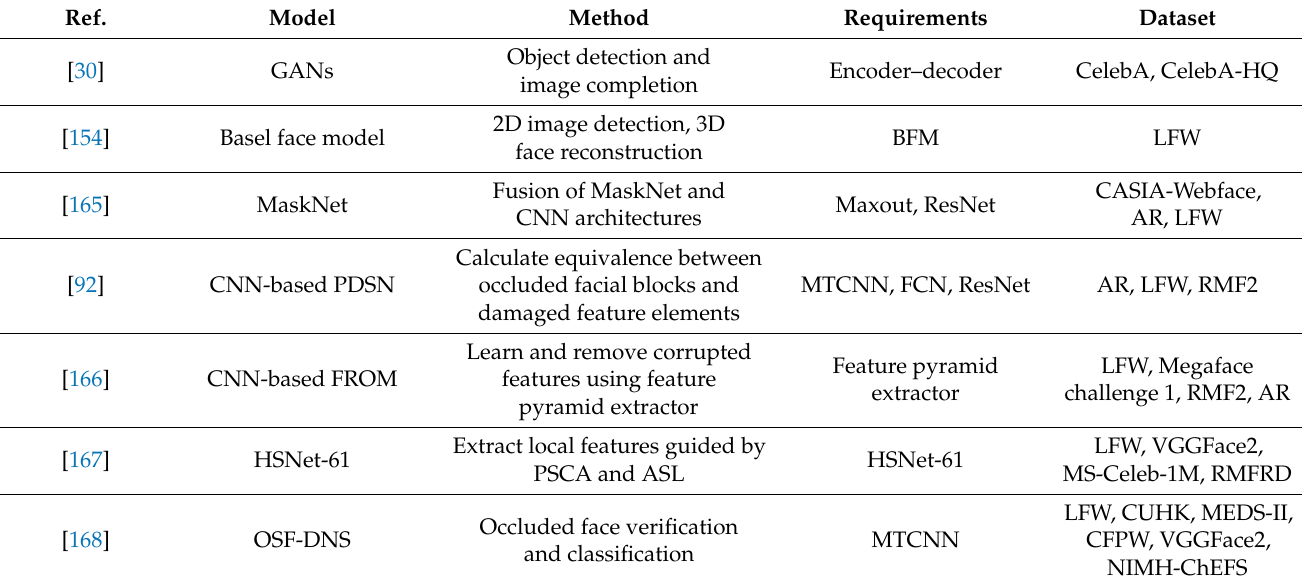
Table 3. A summary of OFR